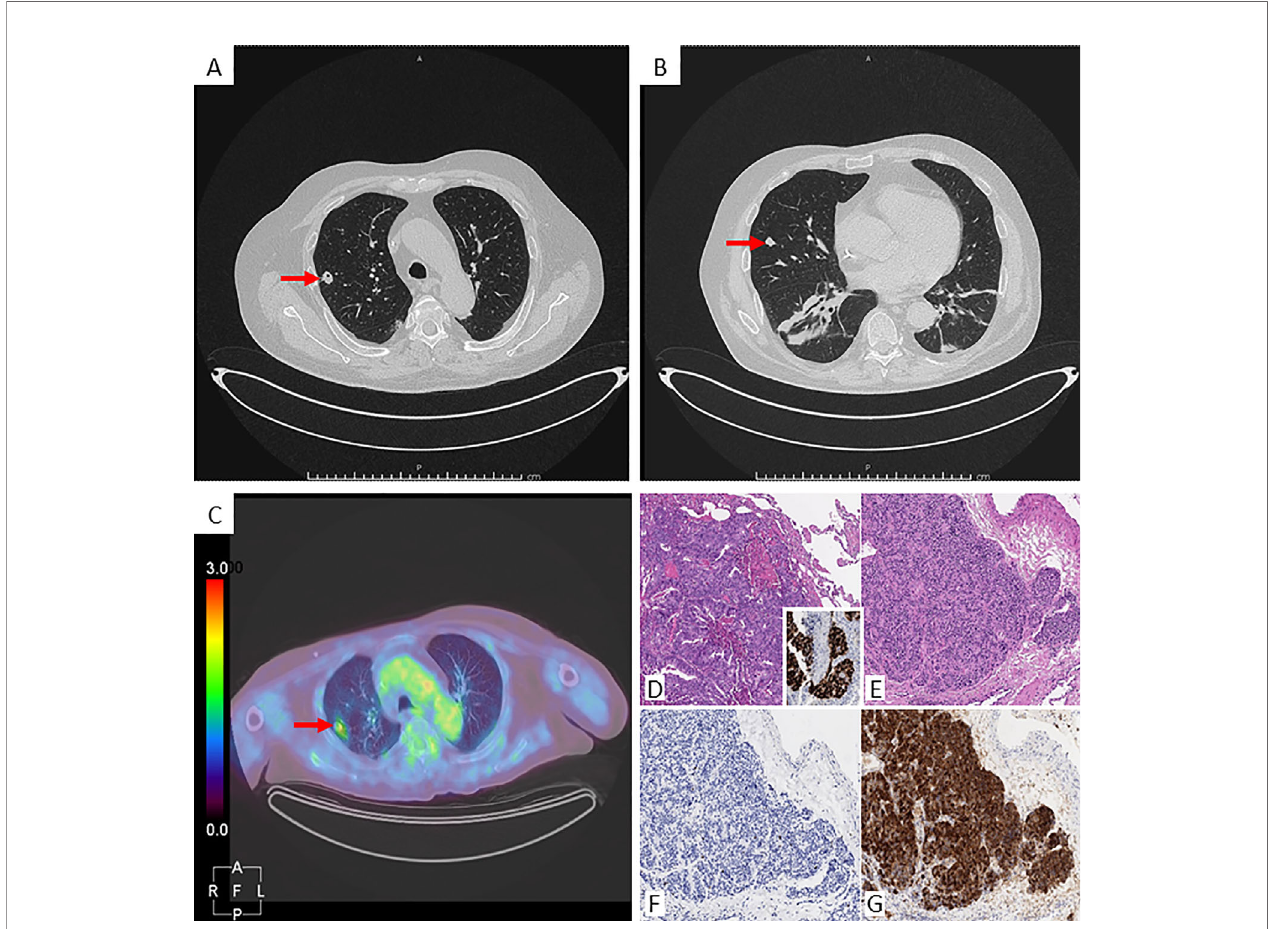
FIGURE 2 | Radiological images and histological panel of the lung nodules. Chest CT scan: (A) nodule in the right superior lobe (arrow), axial projection; (B) nodule in the right middle lobe (arrow), axial projection. [ 18 F]-FDG-PET/CT: (C) uptake of the right superior nodule (arrow), axial projection. Histological panel: the nodule from the superior right lobe ( D Hematoxylin-Eosin, 100x) consists of a metastatic carcinoma, with its colo-rectal primitivity con fi rmed upon CDX2 positivity at immunohistochemistry (inset). Detail from the middle lobe nodule lobe ( E Hematoxylin-Eosin, 100x) depicts an epithelial neoplasm growing in an organoid fashion, composed of bland-looking cells with low mitotic rate and proliferative index ( F Ki67/Mib1, 100x), estimated within a 1-2% range, and featuring intense positivity for ACTH at immunohistochemistry ( G